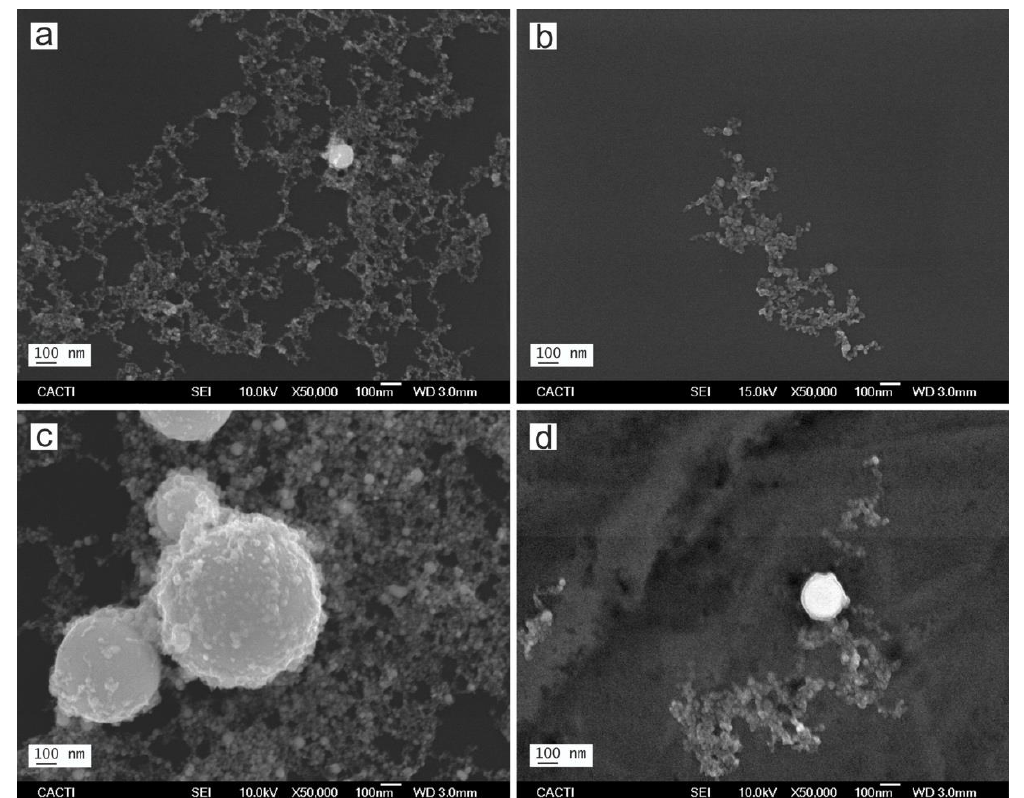
Figure 3. FESEM micrographs of Pd nanoparticles synthesized by laser ablation with ( a ) 532 nm of wavelength in water, ( b ) 532 nm in methanol, ( c ) 1064 nm in water and ( d ) 1064 nm in methanol.